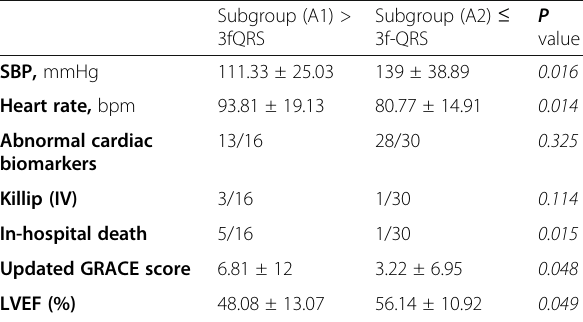
Table 3 The important results of the 2 subgroups (A1) and